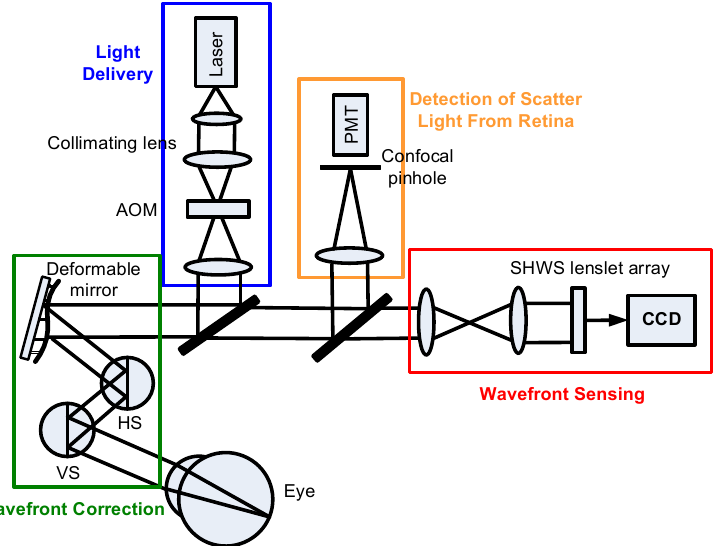
Figure 5. Simplified schematic diagram of an AO-SLO optical system.